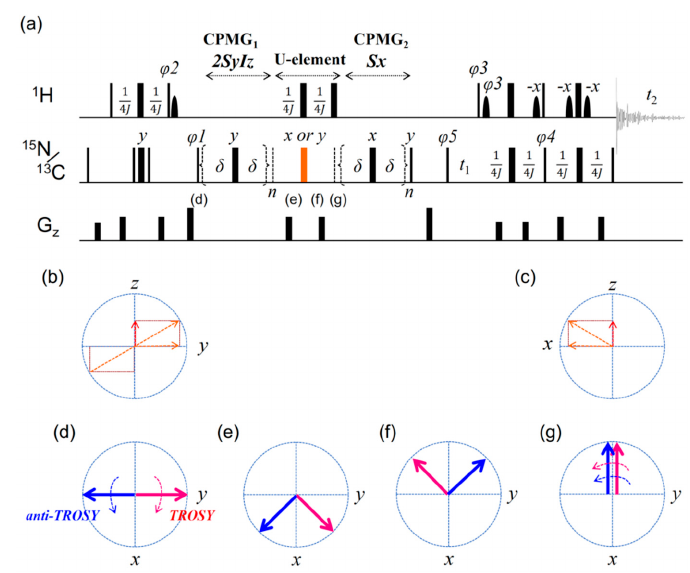
Figure 1. ( a ) A scheme of the transverse relaxation optimized spectroscopy (TROSY)-based rc Carr-Purcell-Meiboom-Gill (CPMG) rd pulse sequence used in the experiments for amide 1 H/ 15 N and aromatic 1 H/ 13 C spin systems. Narrow and wide bars depict 90 ◦ and 180 ◦ pulses, respectively. All pulses were applied with phase x , unless indicated otherwise. The 1 H pulses were applied at the water resonance with an rf field strength of 25 kHz (10.0 µ s as a π /2 pulse width), except for bell-shaped pulses, which were applied as a 1 ms water-selective π /2 sinc-shaped pulse. All 15 N and 13 C pulses were applied at 119 and 125 ppm with rf field strengths of 6250 and 12,500 Hz (40 and 20 µ s as π /2 pulse widths), respectively, at a 1 H static magnetic field strength of 800 MHz. The constant-time CPMG period is divided into two parts (20 ms for each). For each CPMG 1 and CPMG 2 period, a spin-echo, { δ – π – δ }, was repeated n times. J is the scalar coupling constant between the 1 H ( I ) spin and the amide 15 N or aromatic 13 C ( S ) spin. Pulse phases (Bruker) were cycled as follows: φ − x )}, φ 1 = {4( x ), 4( 2 = {8( y ), 8( − y )}, φ 3 = { − y }, φ 4 = { − y }, φ 5 = { y , − x , − y , x }, and φ rec = { y , − x , − y , x , 2( − y , x , y , − x ), y , − x , − y , x }. The 15 N or 13 C indirect dimension was obtained by recording a second data set with, φ 3 → φ 3 + π , φ 4 → φ 4 + π , and φ 5 = { y , x , − y , − x }. For each t 1 increment, φ 5 and φ rec were incremented by π radians ( φ 5 → φ 5 + π and φ rec → φ rec + π ) to shift the axial peaks to the edges of the spectrum; ( b ) The effective magnetic field made by the S spin offset from the carrier frequency, represented by an arrow along the z -axis, and the rf field frequency of the CPMG π pulses along the y -axis in the CPMG 1 period, viewed from the + x direction; ( c ) The effective magnetic field in the CPMG 2 period, viewed from the + y direction; ( d ) The anti-phase magnetization − 2 S y I z at the beginning of the CPMG 1 period, viewed from the + z direction. The TROSY (+ S y I β ) and anti-TROSY ( − S y I α ) magnetization components are represented by red and blue arrows, respectively. For simplicity, any chemical shift evolution is ignored throughout the CPMG 1 , U-element, and CPMG 2 periods. The curved and dashed arrows indicate the rotational direction of the magnetization vectors about the effective magnetic field, when it is assumed that the delay δ is negligibly short. The situation is rather similar to that in S spin lock in T 1 ρ experiments instead of CPMG spin echoes; ( e ) The two magnetizations having evolved by 1 J coupling for the 1/(4 1 J ) period just before application of the spin S π pulse in the U-element; ( f ) The magnetization vectors just after the spin I π pulse and the spin S π pulse of phase y . Both magnetizations will evolve and approach the − x -axis; ( g ) The in-phase magnetization − S x at the start of the CPMG 2 period. The TROSY and anti-TROSY magnetization components are expressed as − S x I β (red) and − S x I α (blue), respectively. When the rotational directions of the magnetizations in the two CPMG periods are compared, it turns out that the anti-TROSY magnetization is rotated about the effective magnetic field in the same sense, while the TROSY magnetization is rotated in the opposite